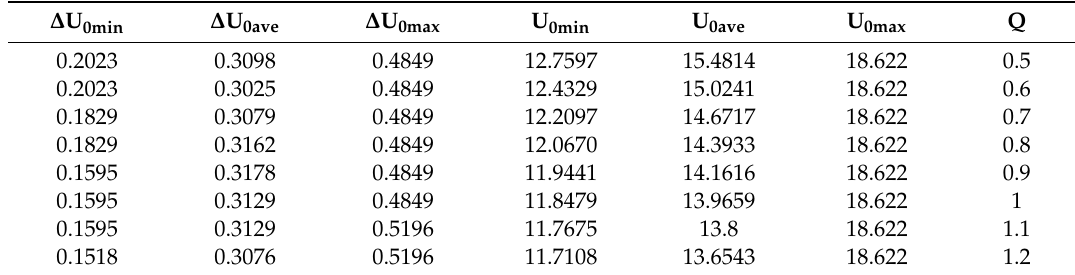
Table 1. Results when changing the resonance chain quality factor.